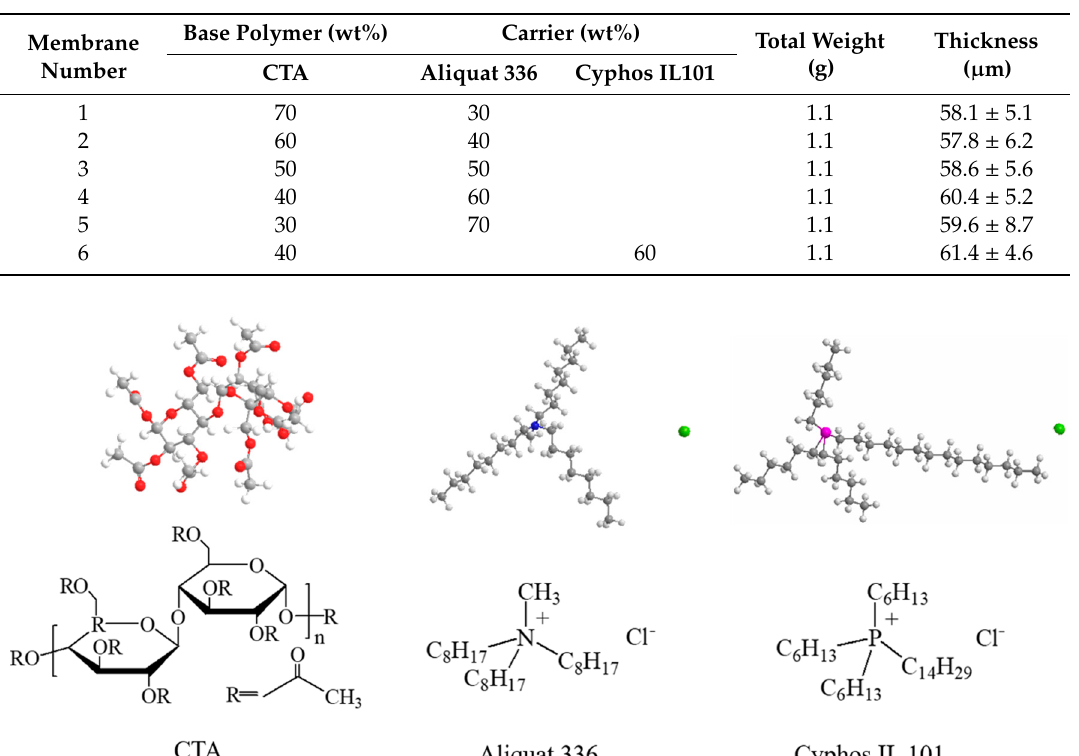
Table 2. The information of the PIM composition and proportion.